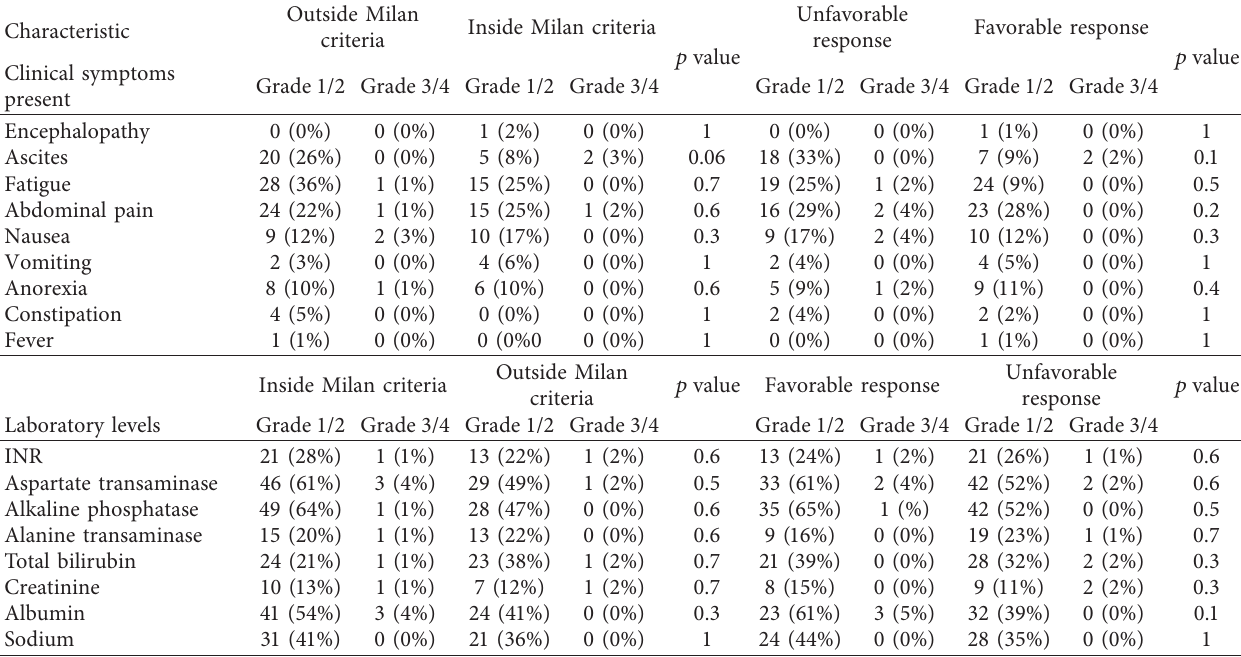
Table 5: Adverse events status after Y90-RE, per Common Terminology Criteria for Adverse Events version